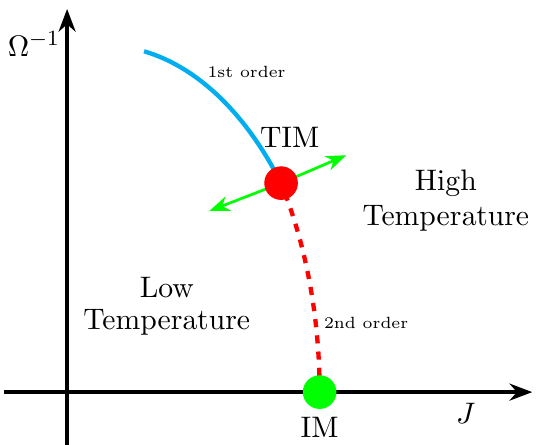
Figure 1.1: Qualitative phase diagram of the TIM in the plane of the two variables J and Ω